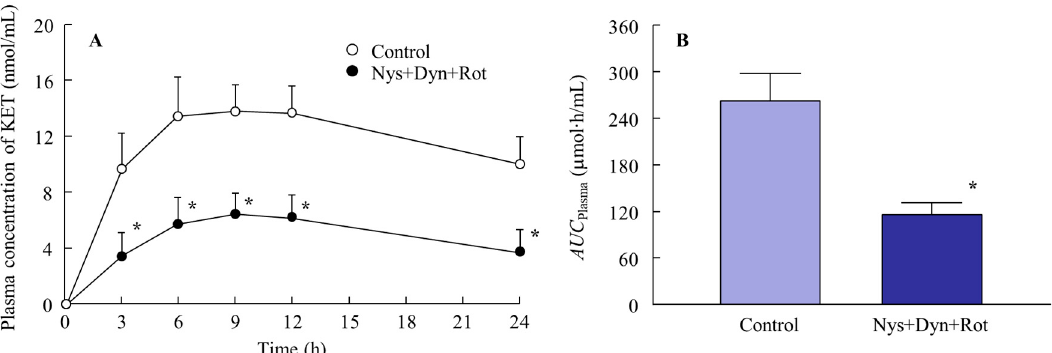
Figure 5. Effect of endocytosis on the percutaneous absorption of ketoprofen released from the KET-NPs formulation. ( A ) Changes in percutaneous absorption from the KET-NPs formulation by multi-treatment with three inhibitors (nystatin, dynasore and rottlerin; Nys + Dyn + Rot); ( B ) Effect of multi-treatment with three inhibitors (nystatin, dynasore and rottlerin; Nys + Dyn + Rot) on AUC Plasma in rats treated with the KET-NPs formulation. Mean ± S.E. n = 6. * p < 0.05 vs. control for each category. The percutaneous absorption of from the KET-NPs formulation was attenuated by the inhibitory effects of CavME, CME and MP.